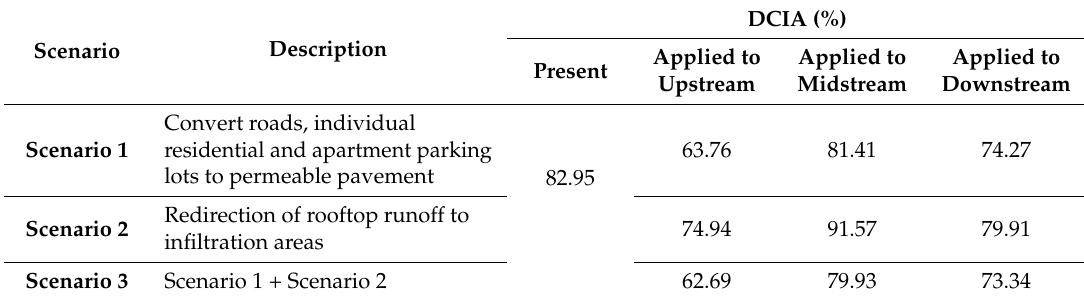
Figure 8. DCIA reduction scenario maps (red areas) where two types of green infrastructure were applied: ( a ) permeable pavement (Scenario 1), ( b ) redirection of rooftop runoff to infiltration areas (Scenario 2), and ( c ) Scenario 1 + Scenario 2 (Scenario 3). Table 4. DCIA reduction scenarios for the test catchment. Table 4. DCIA reduction scenarios for the test